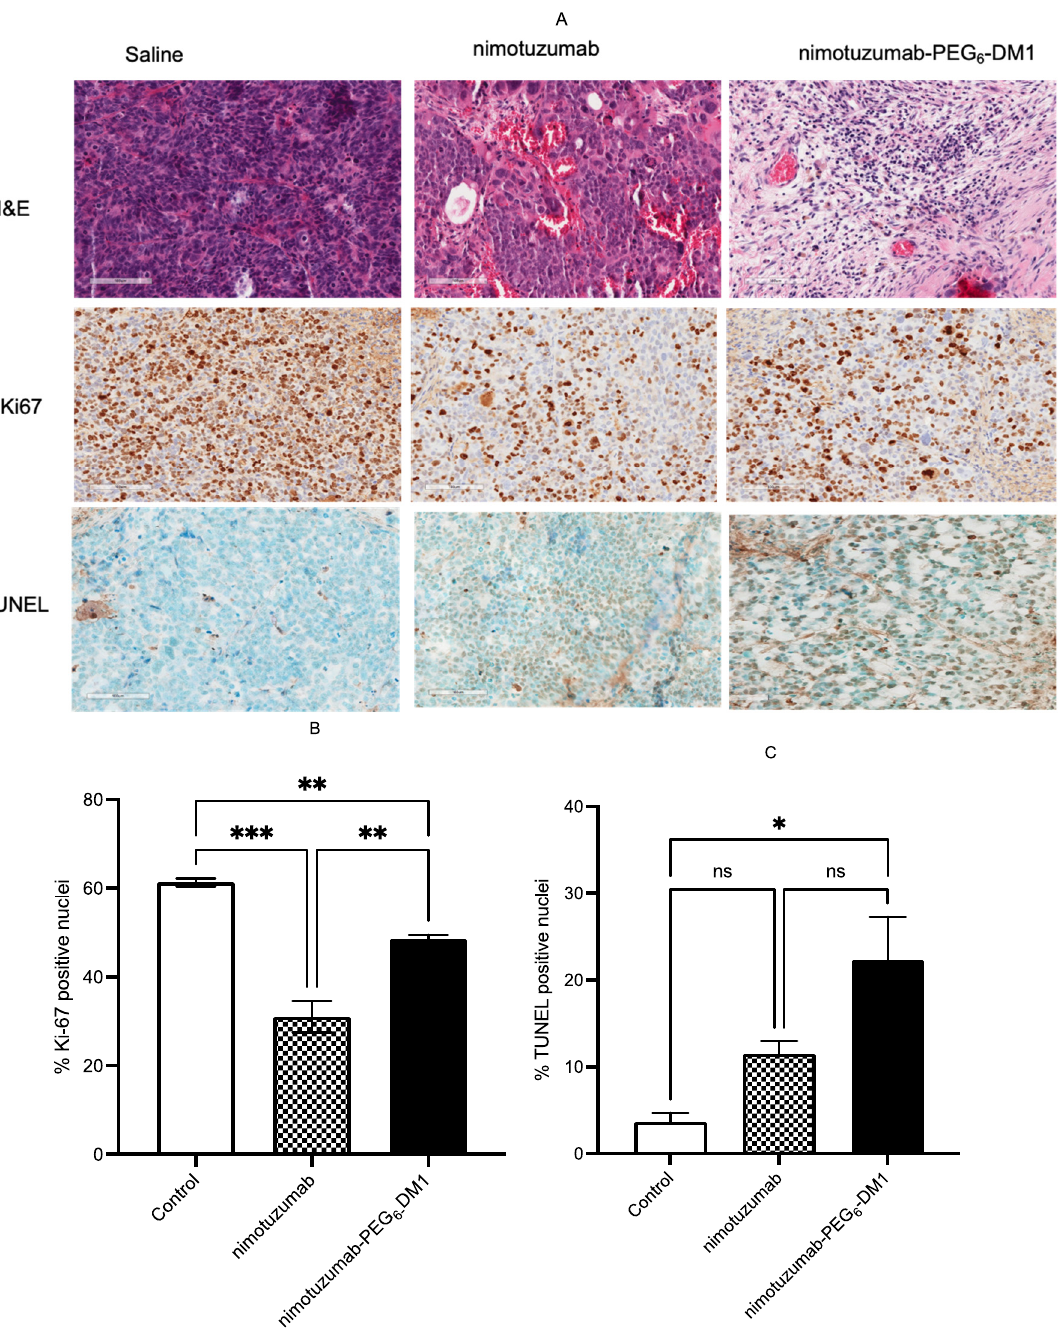
Figure 9. Histological analyses of in vivo treated and untreated mice. ( A ) H&E, TUNEL, and Ki-67- stained tumor sections collected from mice at 51 days after treatment Scale bar 100 μ m). ( B ) Bar chart representation of Ki-67-positive nuclei, and ( C ) bar chart representation of TUNEL positively stained nuclei. (ns = not significant ( p > 0.05), * = significant ( p < 0.05), ** = significant ( p << 0.05), *** = highly significant ( p <<< 0.05).